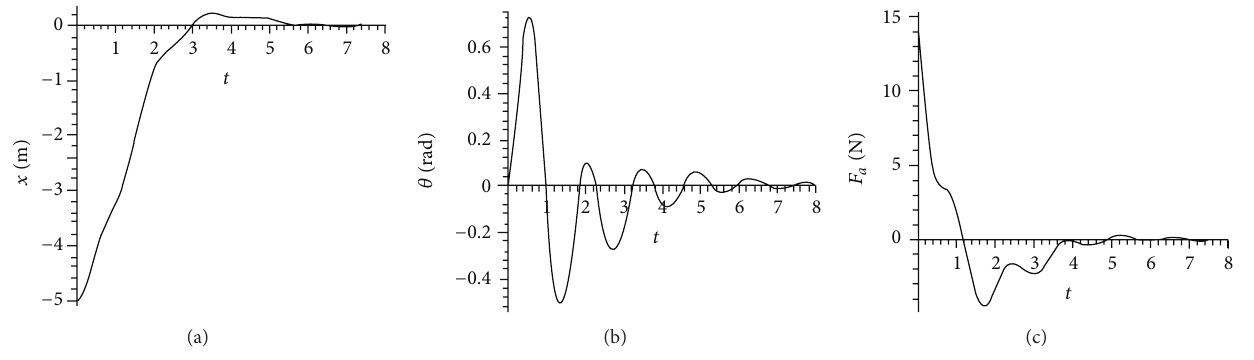
Figure 3: Histograms of (a) cart trajectory, (b) swing angle, and (c) optimal force from